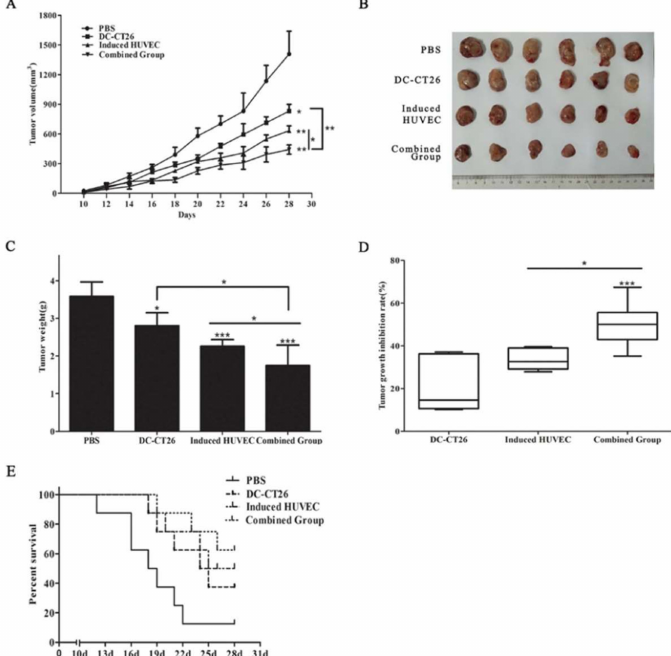
Figure 4. The combination of DC-CT26 with induced HUVECs possessed better antitumor e ff ects than the two single-vaccine groups. ( A ) Tumor growth was measured every other day after day 10. ( B ) Tumors of each group were photographed after being stripped from mice. ( C ) Tumor weight was tested after removal from mice. ( D ) Tumor growth inhibition rate was calculated from the results of tumor weight. ( E ) Survival data of each group was compared, (* p < 0.05; ** p < 0.01; *** p <